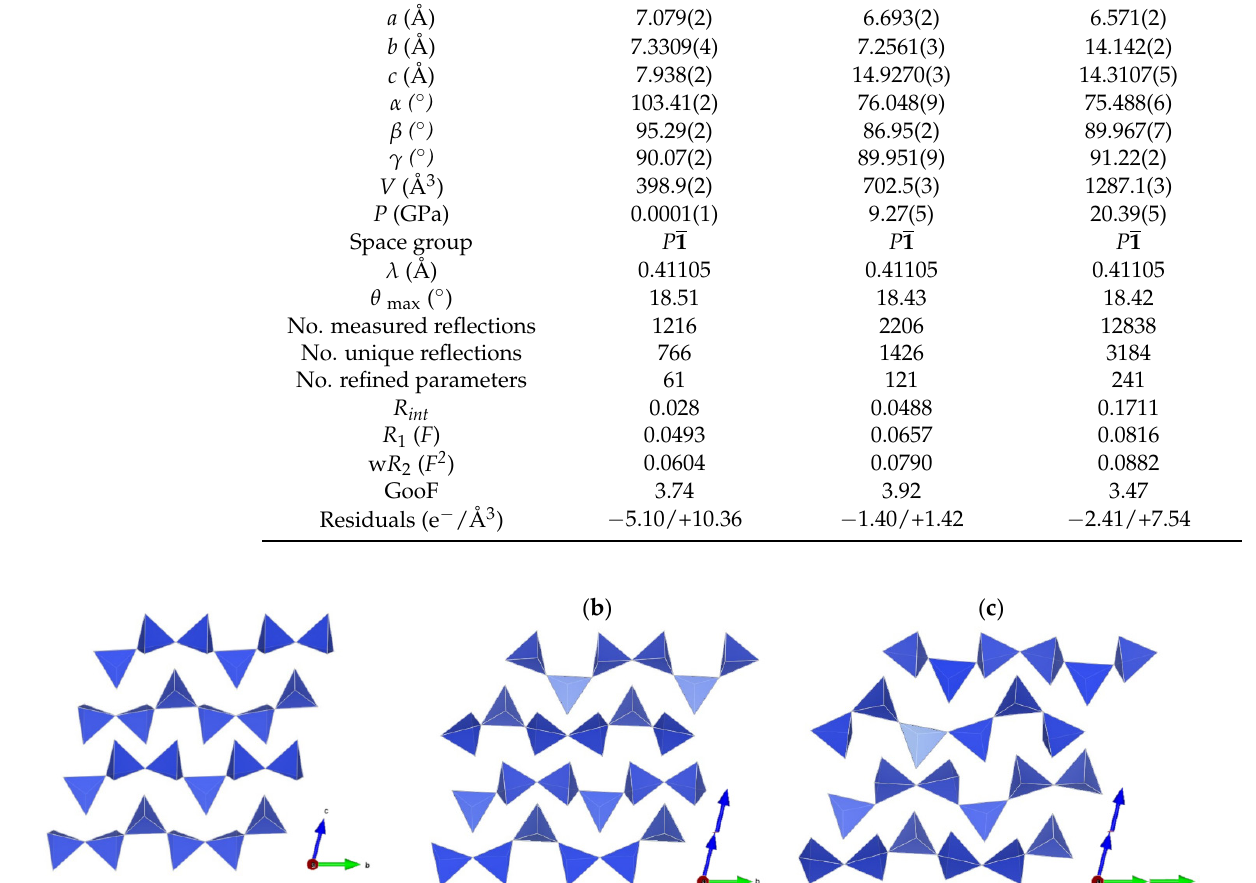
Table 4. Lattice parameters of CaSiO 3 -walstromite at different pressures, collected using helium as P -transmitting medium ( P -uncertainty: ±0.05 GPa). P (GPa)